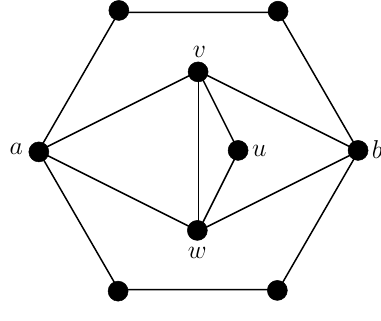
Figure 4: The graph G if H = C 6